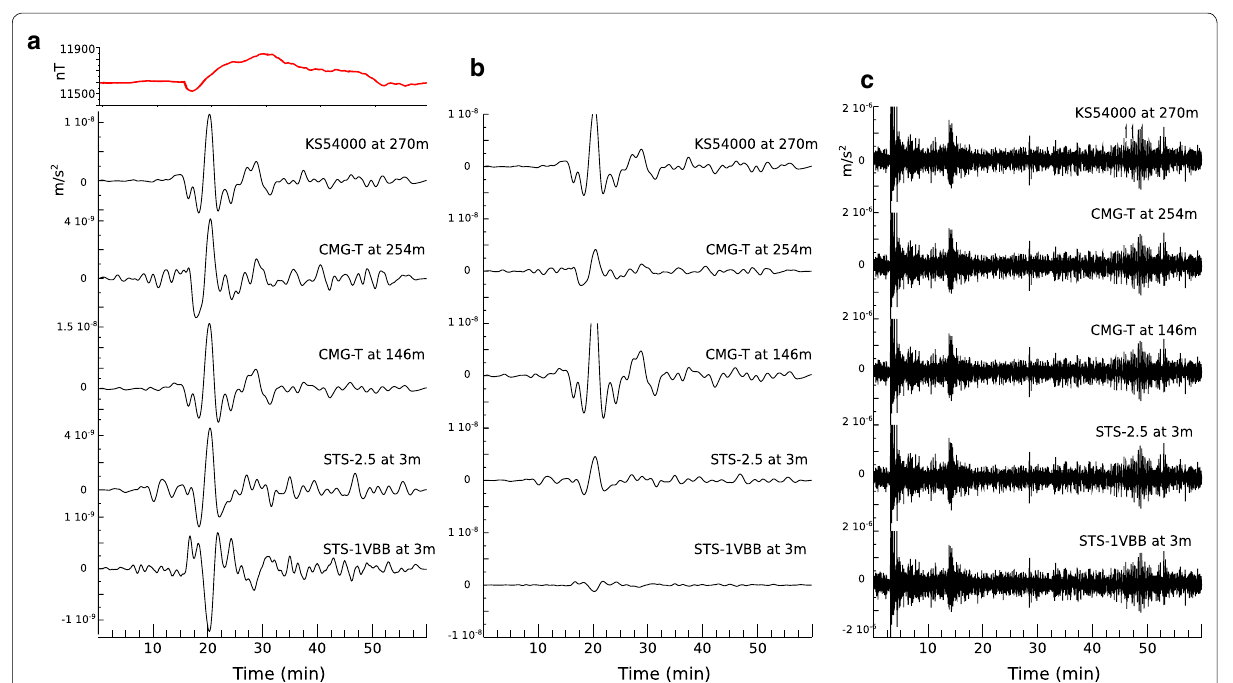
Fig. 4 Seismic signals at QSPA station (South Pole). a Top panel: magnetic field (H) recorded at the SBA magnetic observatory, located at the Scott Base (77.85º S, 166.78º E). Bottom panel: seismic acceleration records during the 2014/12/23 SSC event at the different sensors of the QSPA site, represented in normalized amplitudes. b Same data represented using a common amplitude scale. c Seismic records of an M 6.3 earthquake with epicenter in Indonesia represented in true